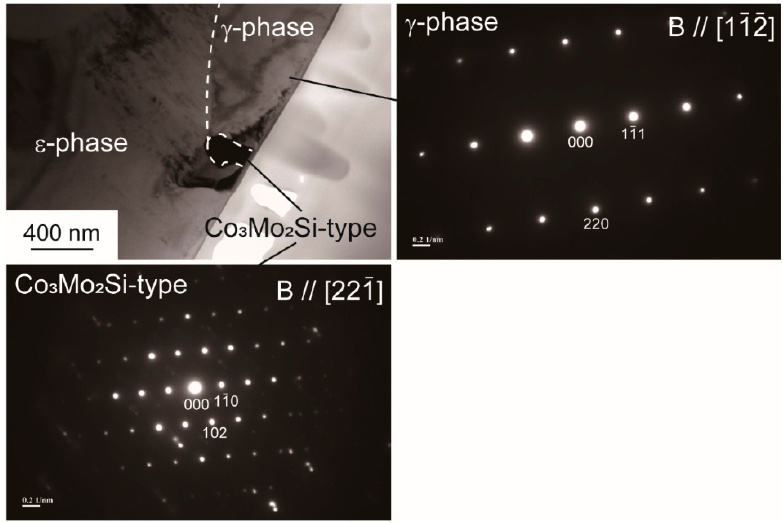
Figure 11. TEM-BF image and SADPs of the γ -phase and Co 3 Mo 2 Si-type precipitates that were observed in the middle RT 80 specimen of the low-C alloy.